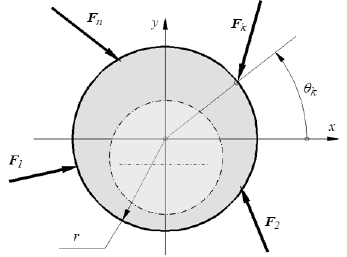
Figure 5. Compact disk loaded by concentrated forces.